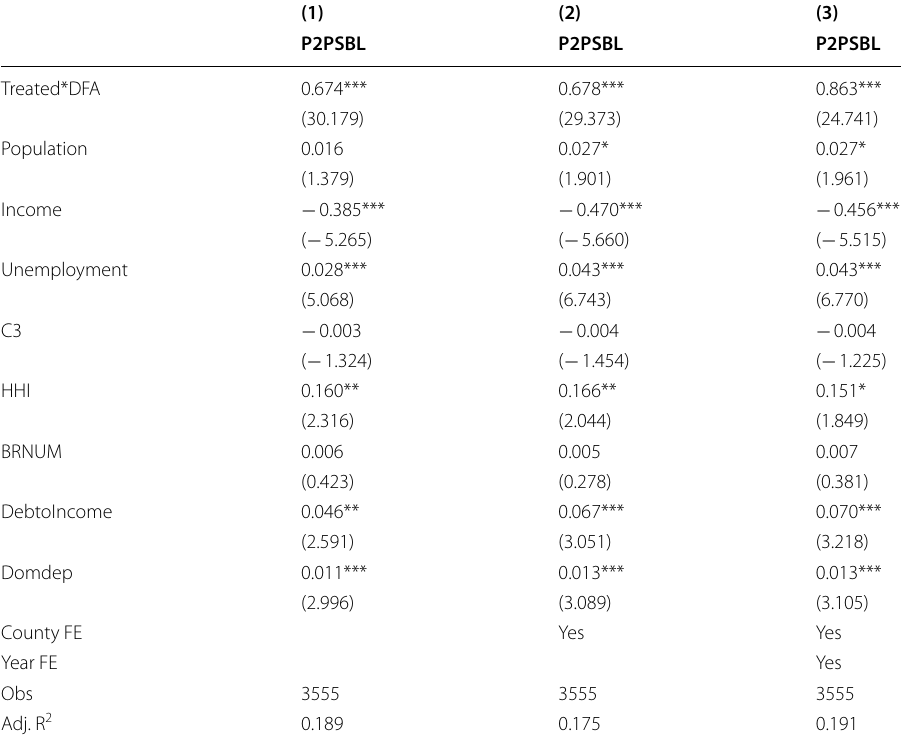
Table 7 Impact of Dodd-Frank Act on aggregate alternative P2P